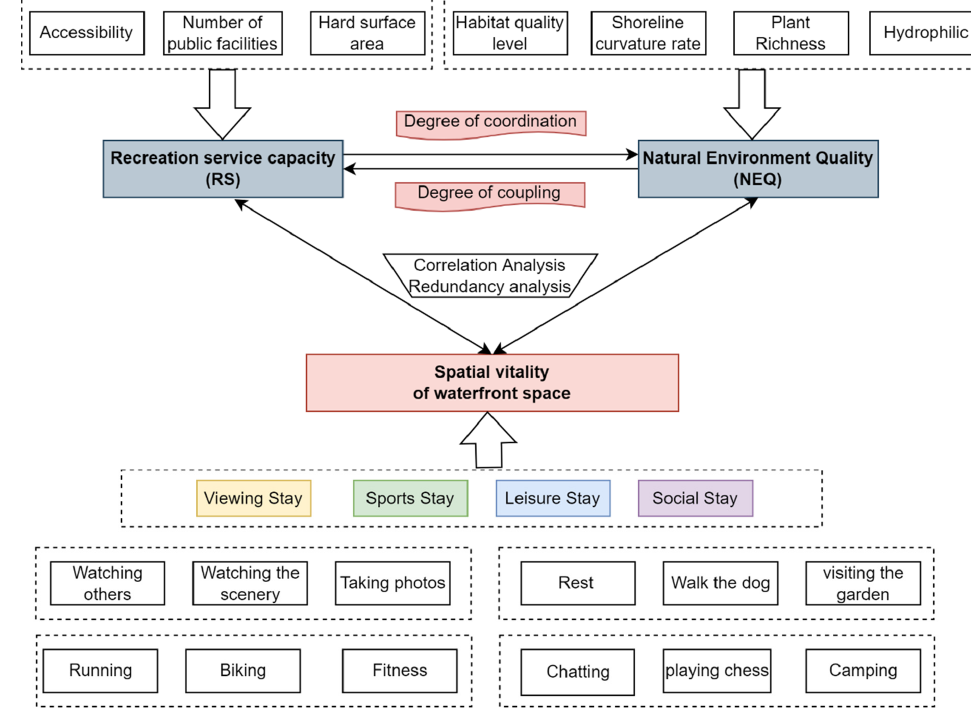
Figure 3. Indicator procedure diagram.